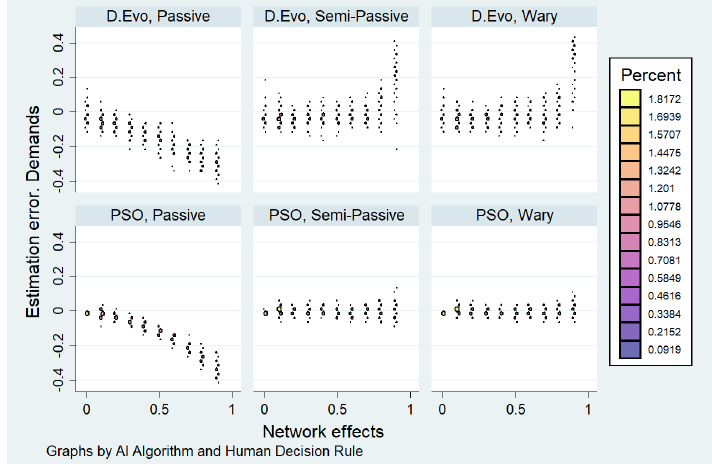
Figure 5. Demand estimation error. Source: Own.